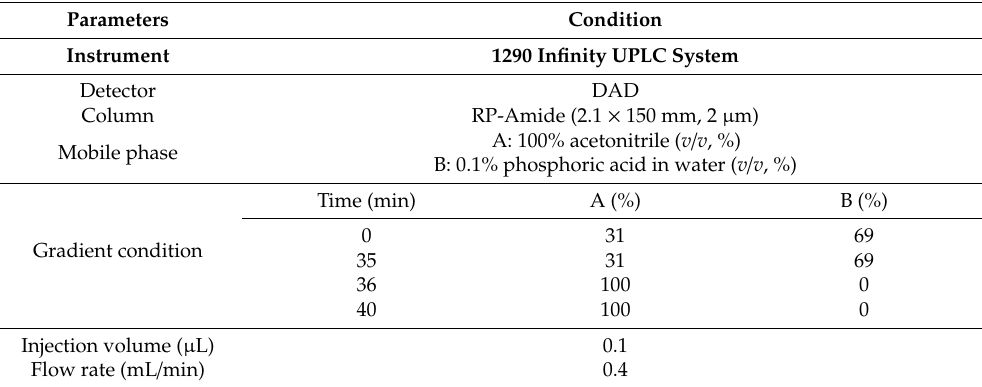
Table 1. The condition of analysis of AGE by UPLC